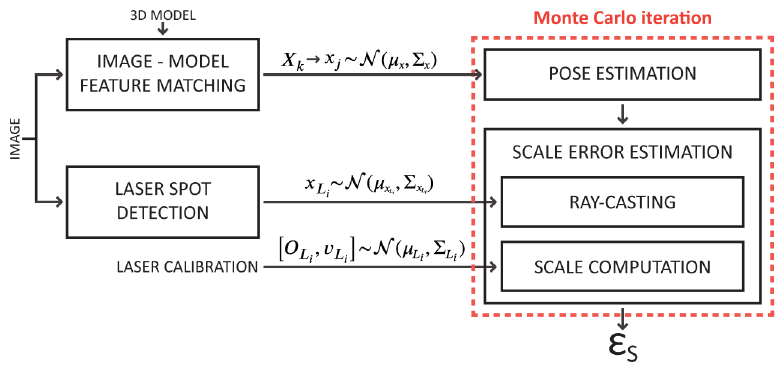
Figure 6. Monte Carlo simulation scheme used for propagating input uncertainties through the process of scale error estimation.